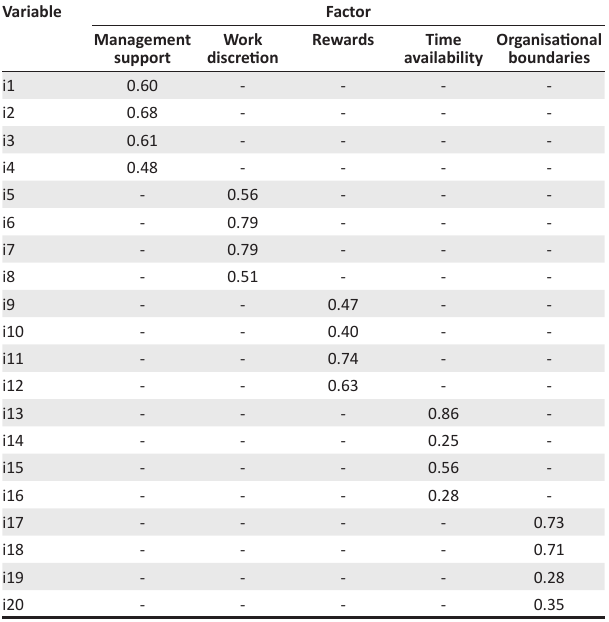
TABLE 4: Standardised factor loadings of the Brief Corporate Entrepreneurship Assessment Instrument items for men and women jointly. Variable Factor Management support